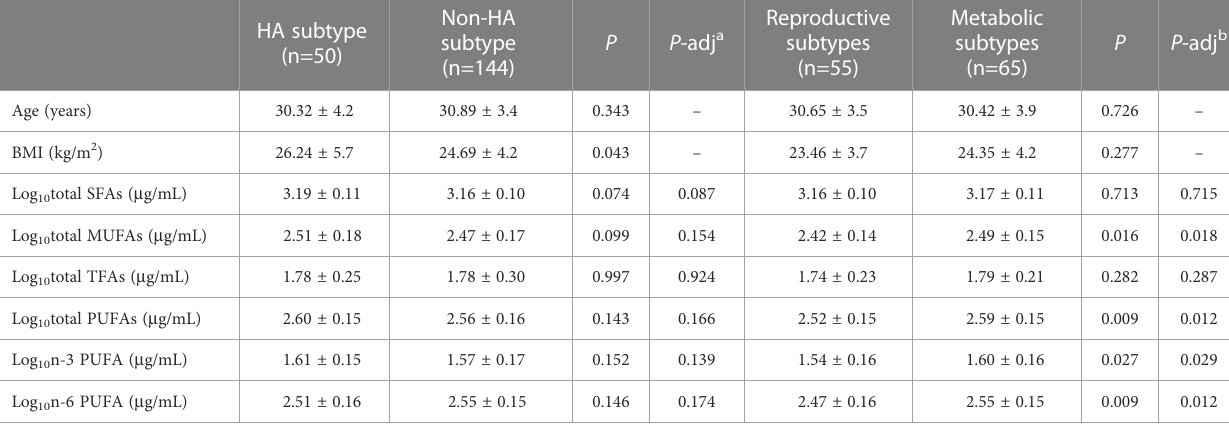
TABLE 2 Distributions of serum fatty acids in various PCOS subtypes.